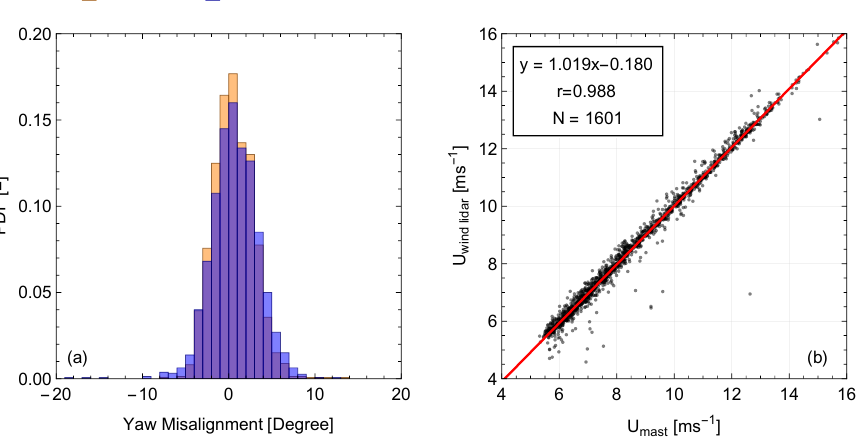
Figure 13. ( a ) The histogram of the yaw misalignment estimated using the measurements of the wind direction at the meteorological mast and the yaw direction of the wind turbine. ( b ) Scatter plot of the magnitude of the mean horizontal wind speed vector measured by a cup anemometer (Umast) and the SpinneLidar (U wind lidar) at 44